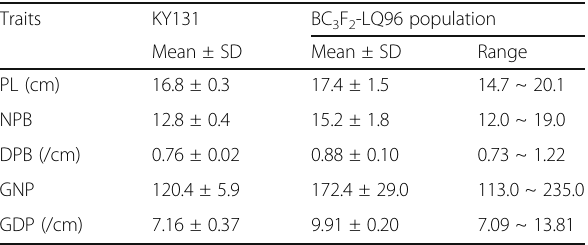
Table 1 Performance of the traits in Kongyu 131 and the using Kongyu 131 as the recurrent parent and GKBR as the donor parent